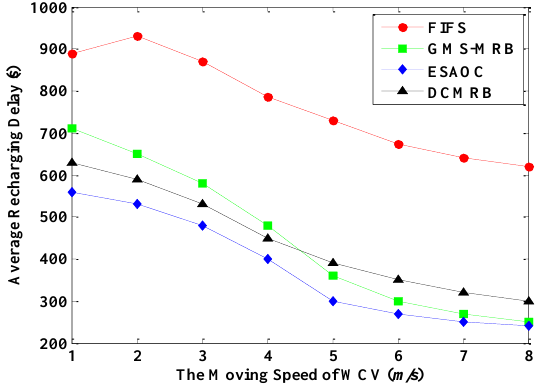
Figure 25. Average recharging delay under different moving speeds.